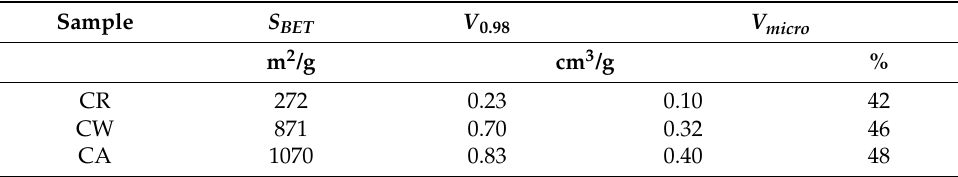
Table 1. Porous characteristics of carbon aerogel samples 1 .